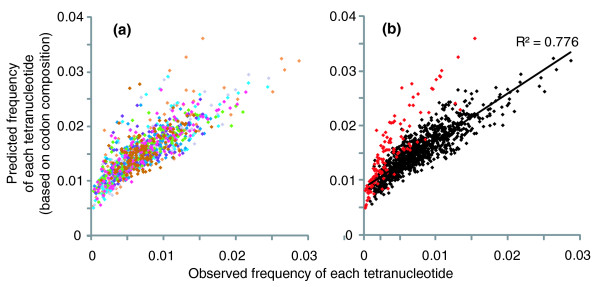
Tetranucleotide frequency predicted by codon abundance (a weighted average of the frequencies of the 12 potential codons associated with each tetranucleotide) versus observed tetranucleotide frequency. (a) Color indicates the genome of origin (using the same color scheme as Figure 3). (b) Palindromic nucleotides are indicated in red. R2 indicates the square of the Pearson correlation coefficient.